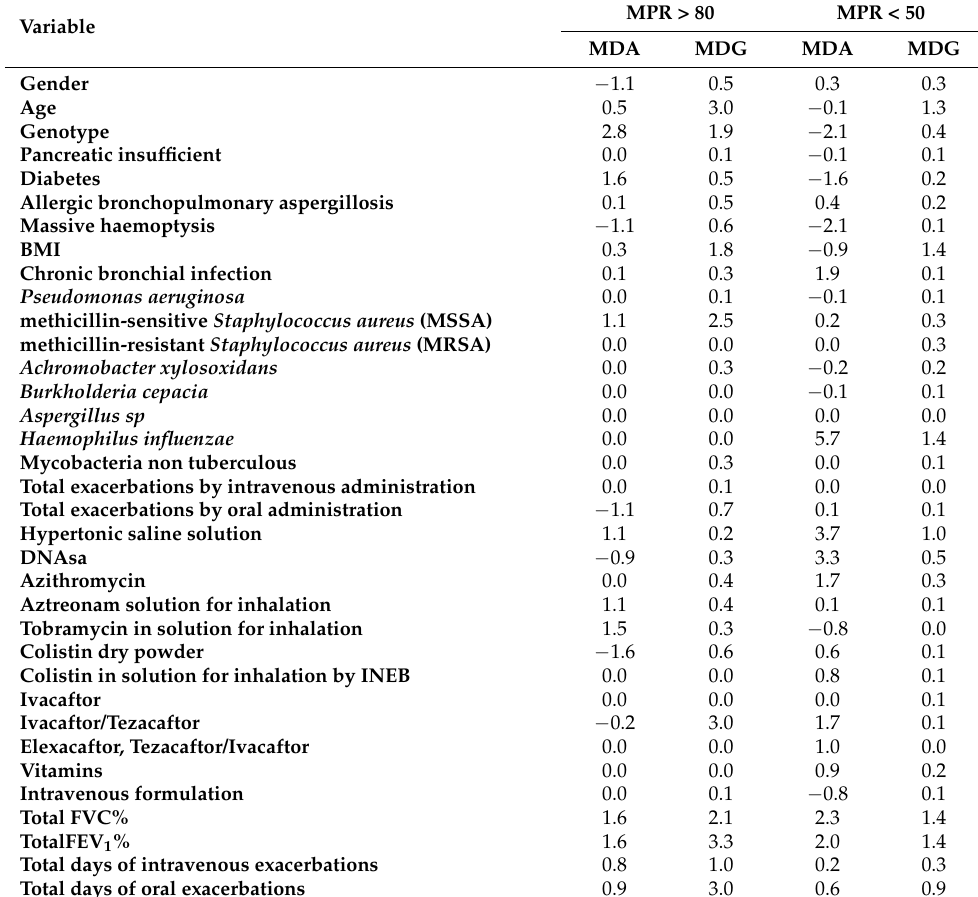
Table 3. Associated Mean Decreases Accuracy (MDA) and Mean Decrease Gini (MDG) of high- importance predictors of MPR > 80 and MPR <